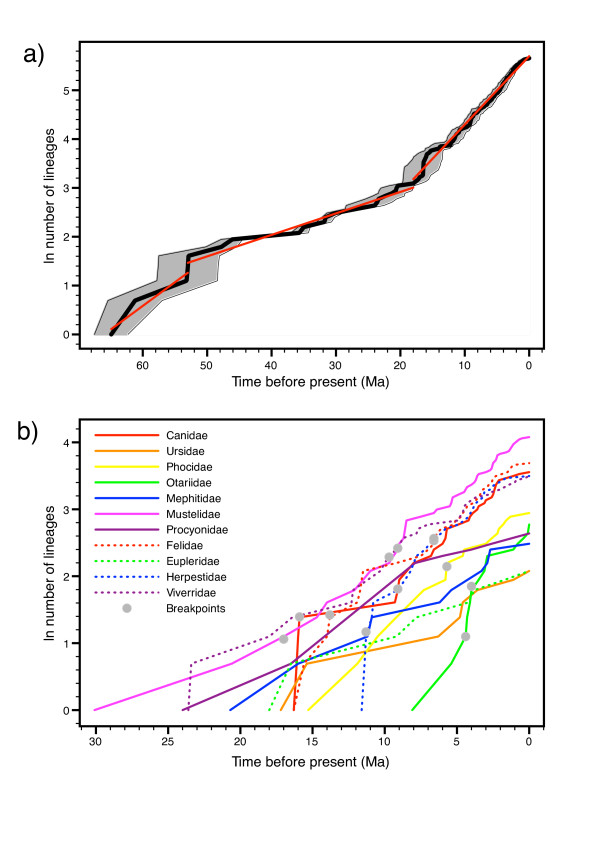
Lineages-through-time plots for the carnivores (a) as a whole and (b) for the individual families. In (a), the thick black line indicates the number of lineages through time according to the best divergence time estimates, with the grey area indicating the numbers according to the upper and lower 95% confidence intervals on these dates; the red lines present the slopes for the three different time segments indicated by goodness-of-fit tests. In (b), only the plots according to the best divergence time estimates are presented.